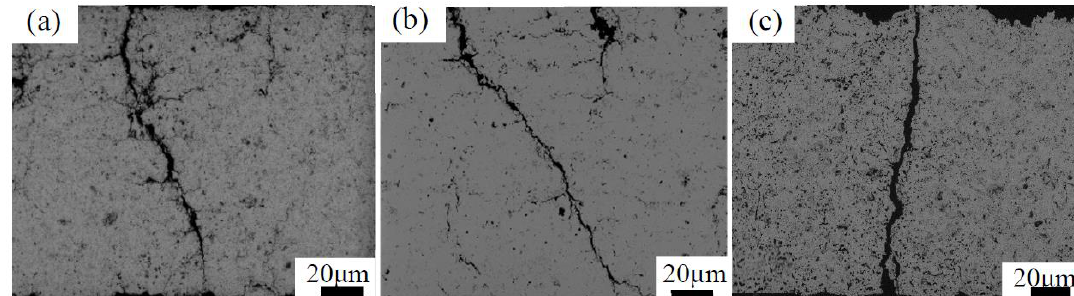
Figure 8. Microstructure of as-sprayed and thermally aged APS coatings: ( a ) as-sprayed; ( b ) at 1600 °C for 24 h; ( c ) at 1550 °C for 100 h.